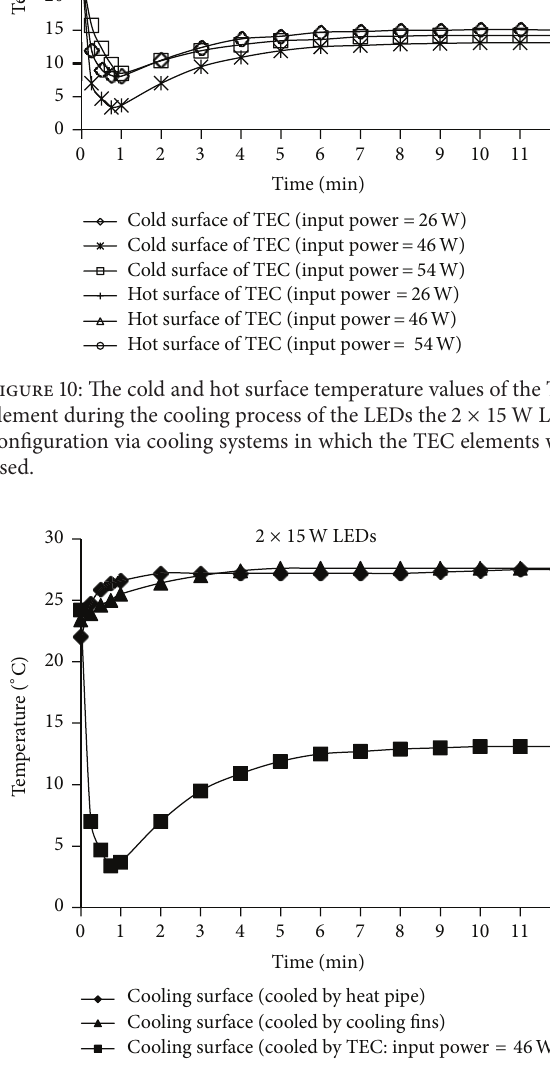
Figure 11: The temperature-time graphics of three different cooling systems used to cool LEDs with 2 × 15 W LEDs configuration.